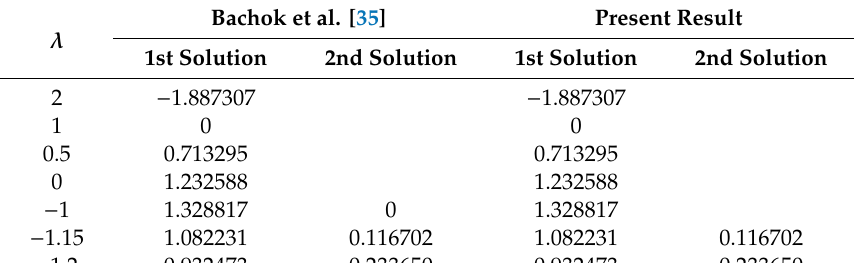
Table 2. Values of f (cid:48)(cid:48) ( 0 ) at selected values of λ when ϕ 1 = ϕ 2 = 0, M = 0.